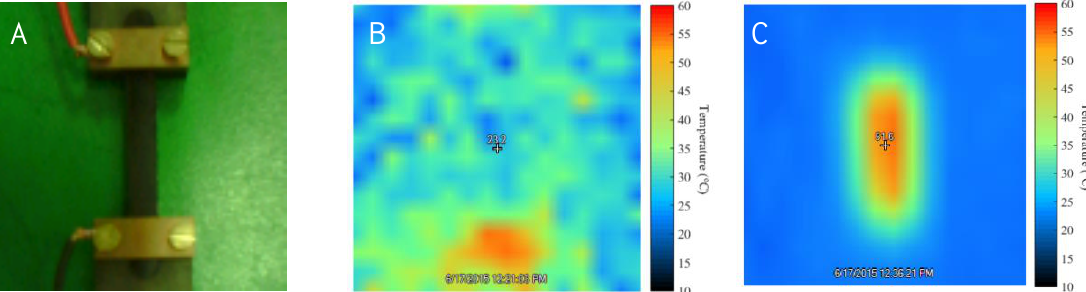
Figure 9. ( A ) Photograph of the PK-Fu/B-Ma/MWCNT composite sample with 5 wt.% of MWCNTs connected to the electrical circuit and its thermal images before ( B ) and during the application of a voltage of 35 V ( C ).